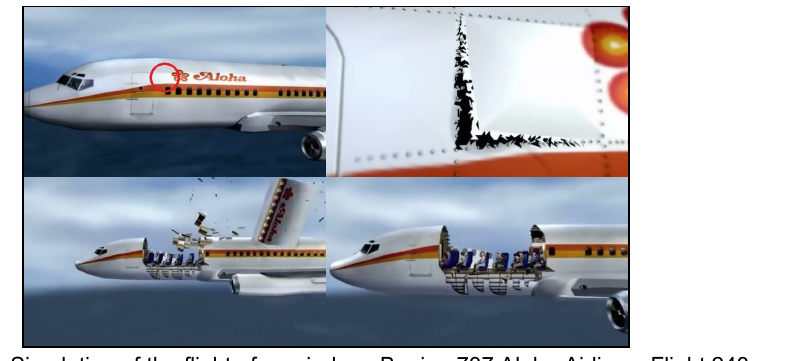
Figure 1 – Simulation of the flight of an airplane Boeing 737 Aloha Airlines, Flight 243 Рис . 1 – Моделирование полета самолета Boeing 737 Aloha Airlines Flight